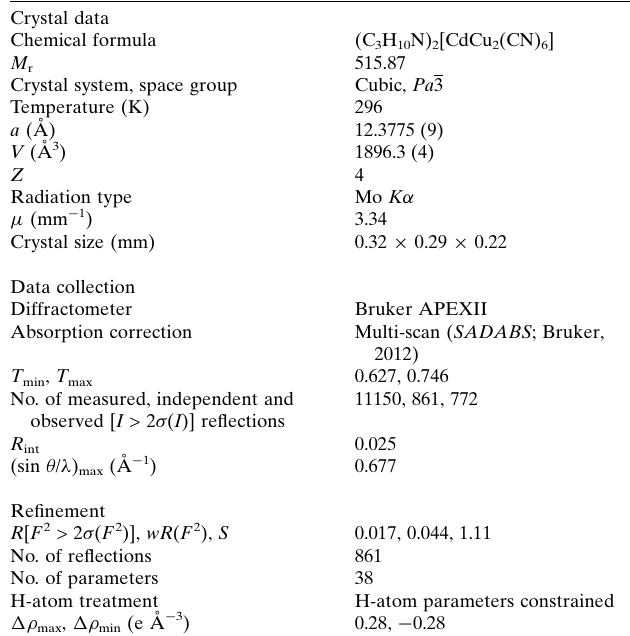
The coordination forms of the Cd II and Cu I ions and the structure of the trimethylammonium ion in the title compound. All displacement ellipsoids are drawn at the 50% probability level. H atoms have been omitted for clarity. [Symmetry codes: (i) – z + 1 z + 1 , (cid:2) x + 1 ; (iii) (cid:2) x + 1, (cid:2) y + 1, (cid:2) z ; (iv) z + 1 2 2 (vi) z , x , y ; (vii) y , z , x